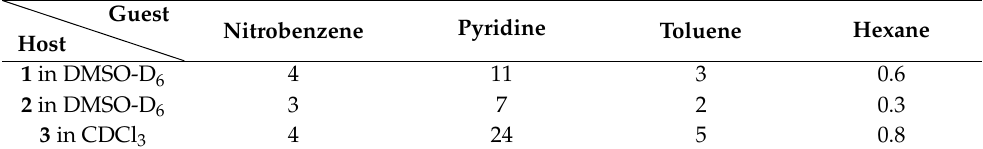
Table 1. The VOC adsorption of dendrimers 1 – 3 .